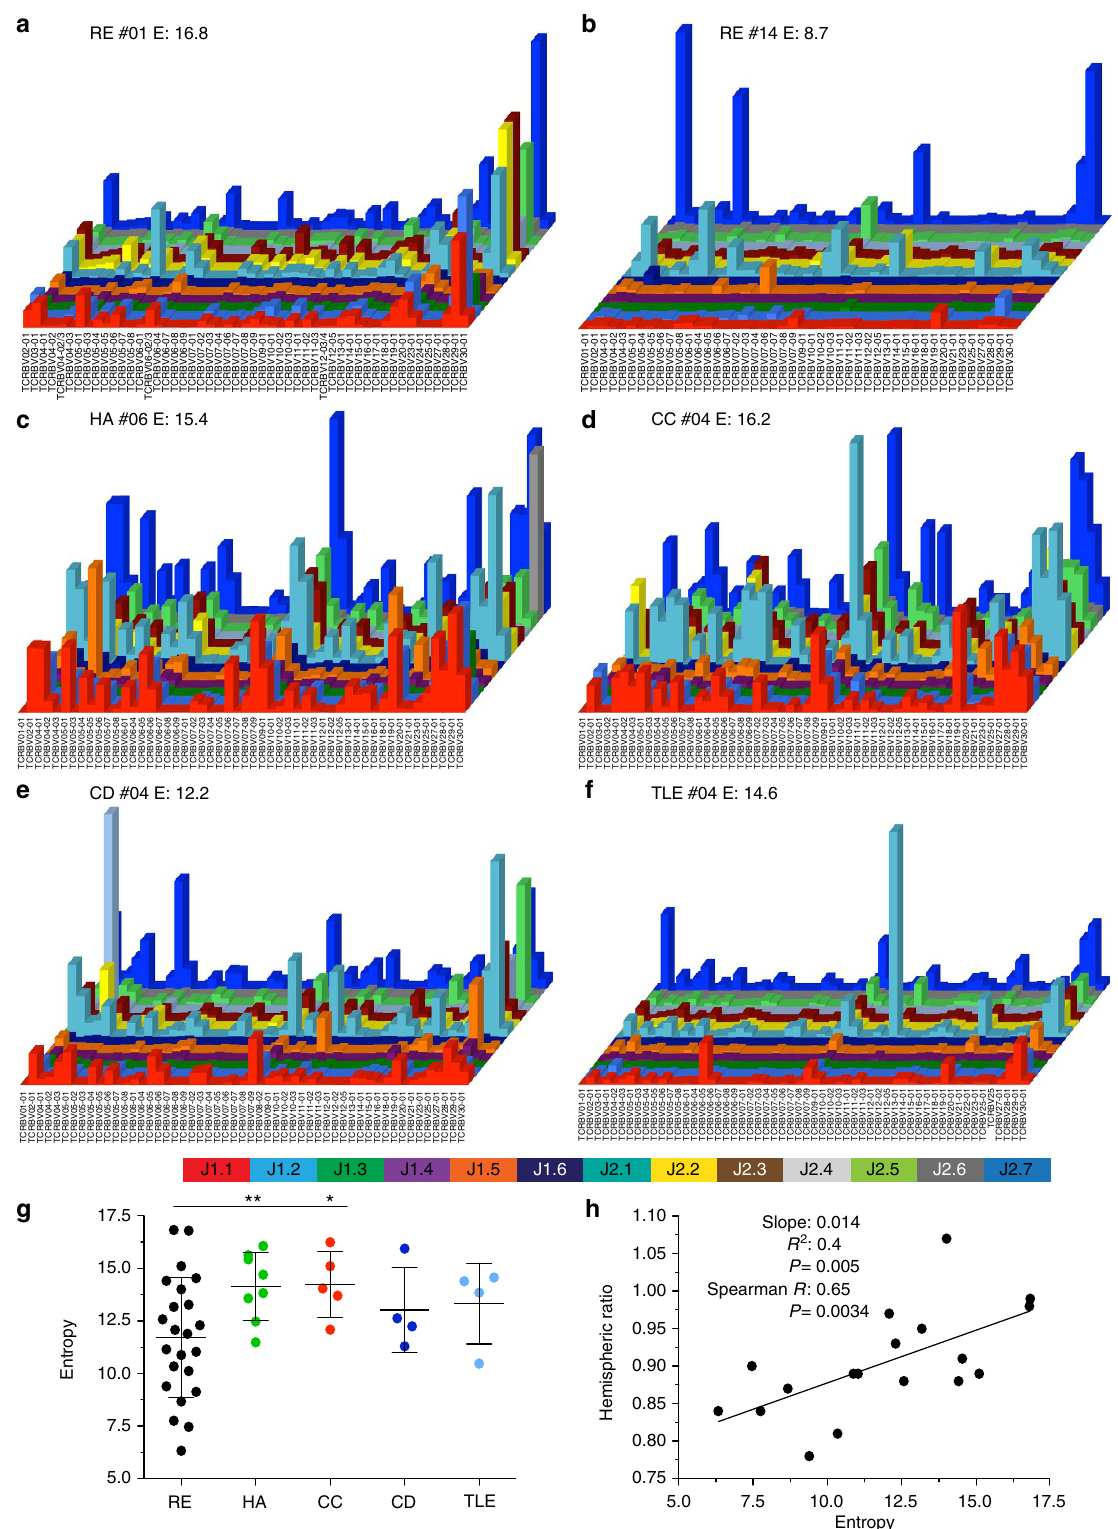
Figure 1 | RE blood CD8 þ TCR entropy correlates with disease severity. Shown are the peripheral CD8 þ TCR repertoires of representative patients for ( a ) RE with high entropy (E), ( b ) RE with low entropy, ( c ) headache (HA), ( d ) common cold (CC), ( e ) CD and ( f ) TLE. The x axis lists all analysed V b genes, the z axis the J b genes and the column height indicates the total reads of this specific V/J combination; ( g ) a quantification of the repertoire diversity by showing the CD8 þ repertoire entropy of each patient group (RE: black, n ¼ 23; HA: green, n ¼ 8; CC: red, n ¼ 5; CD: dark blue, n ¼ 4; TLE: light blue, n ¼ 4, mean ± s.d., unpaired t -test with Welch’s correction). ( h ) Correlation of the RE cohort ( n ¼ 18) with respect to their entropy ( x axis) and disease severity (hemispheric ratio; y axis) (non-parametric Spearman correlation with Gaussian